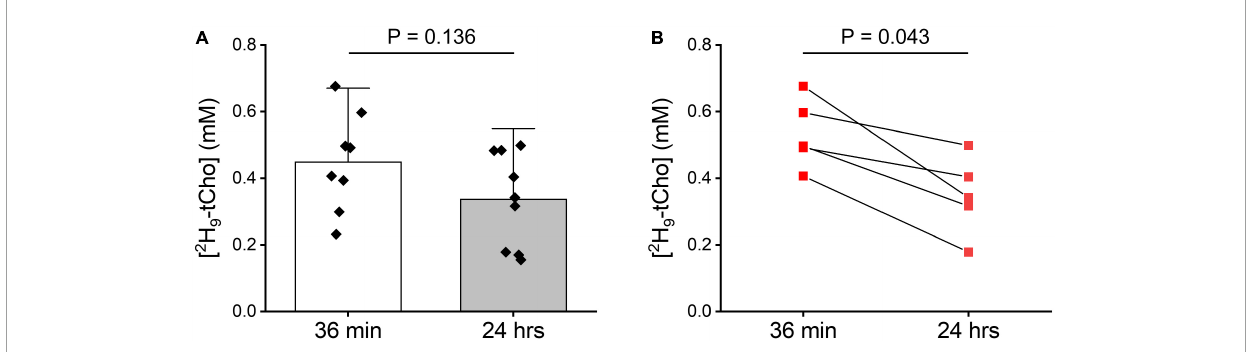
FIGURE5 Tumor 2 H-tCho concentration measured in vivo . (A) Average tumor 2 H-tCho levels (mM) from DMI data acquired during the 36 min infusion of 2 H 9 -Cho, and 20–24 h later. Bar graphs indicate mean and standard deviation, with individual data points overlaid. 36 min: n = 8; 24 h: ( n = 9). Statistics based on T -test. (B) Subset of data shown in panel (A) of animals ( n = 5) for which a pair of 36 in and 24 h data were collected. Statistics based on Wilcoxon Rank test.